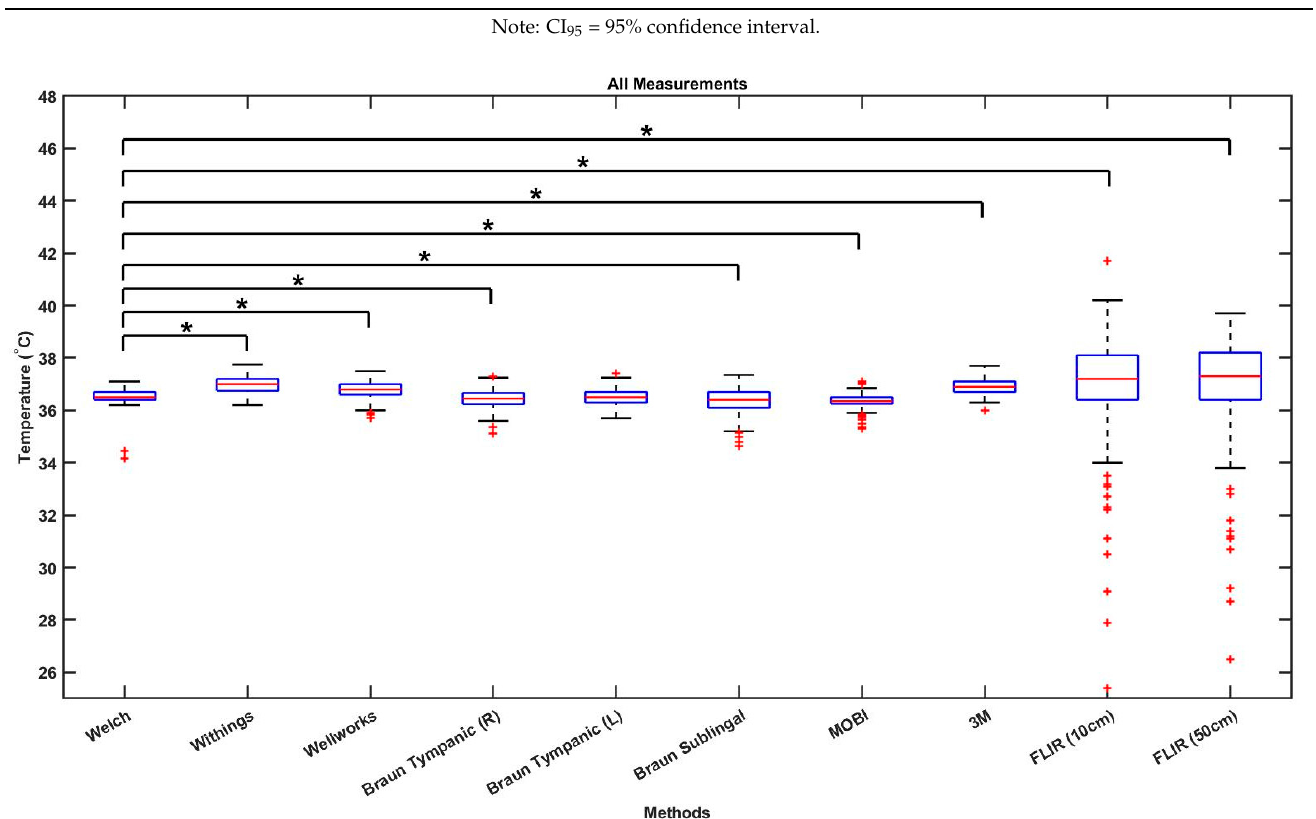
Withings Wellworks Table 2. Mean difference, standard deviation and 95% confidence interval between each device and the gold standard. Withings